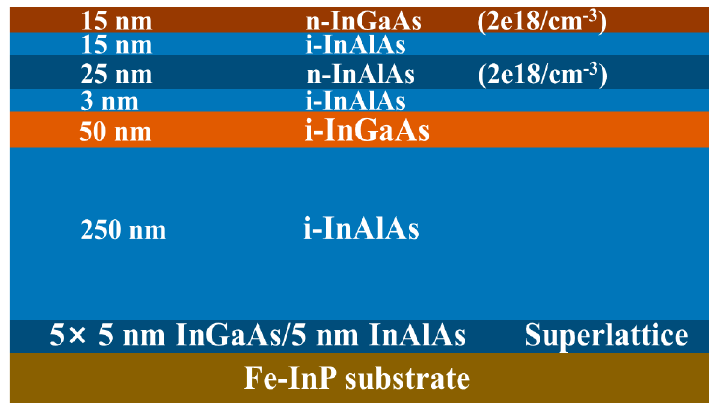
Figure 56. Layer structure of the first HEMT device based on InP.